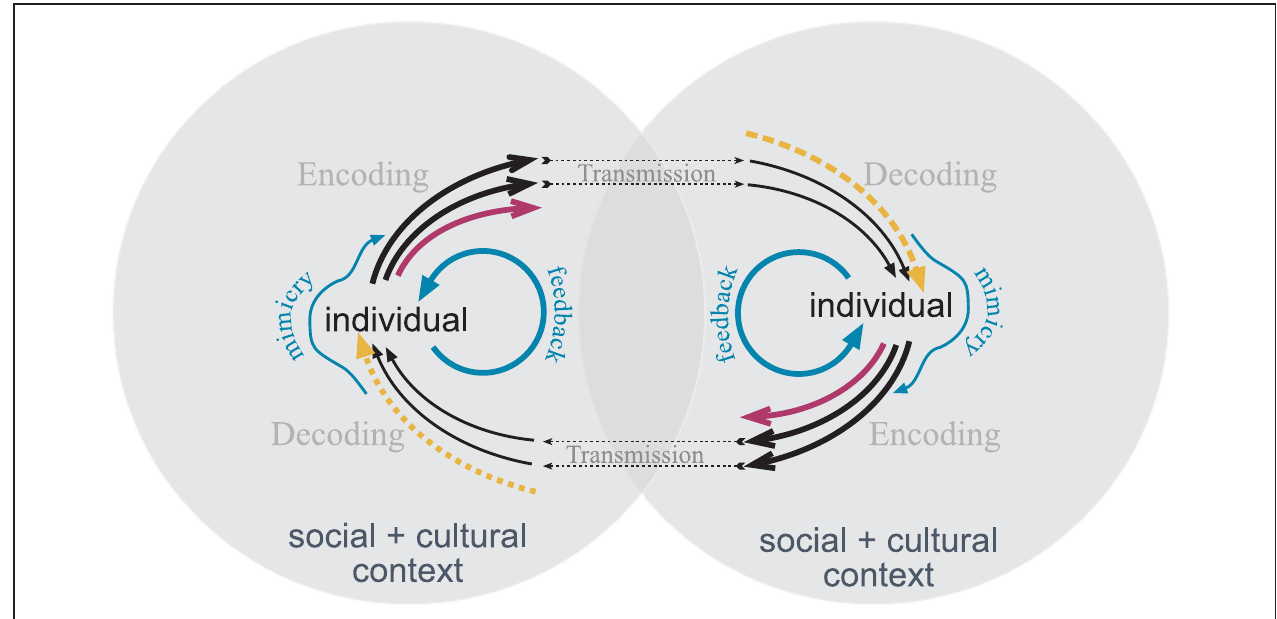
FIGURE 2 | Superlens model adapted from Kappas (1991) and Kappas and Descôteaux (2003). Communication pathways are indicated in black, expressive regulatory pathways in blue. Red arrows indicate objectively measurable displays that are not transmitted/received. Yellow arrows indicate erroneously perceived displays, for example due to stereotypes